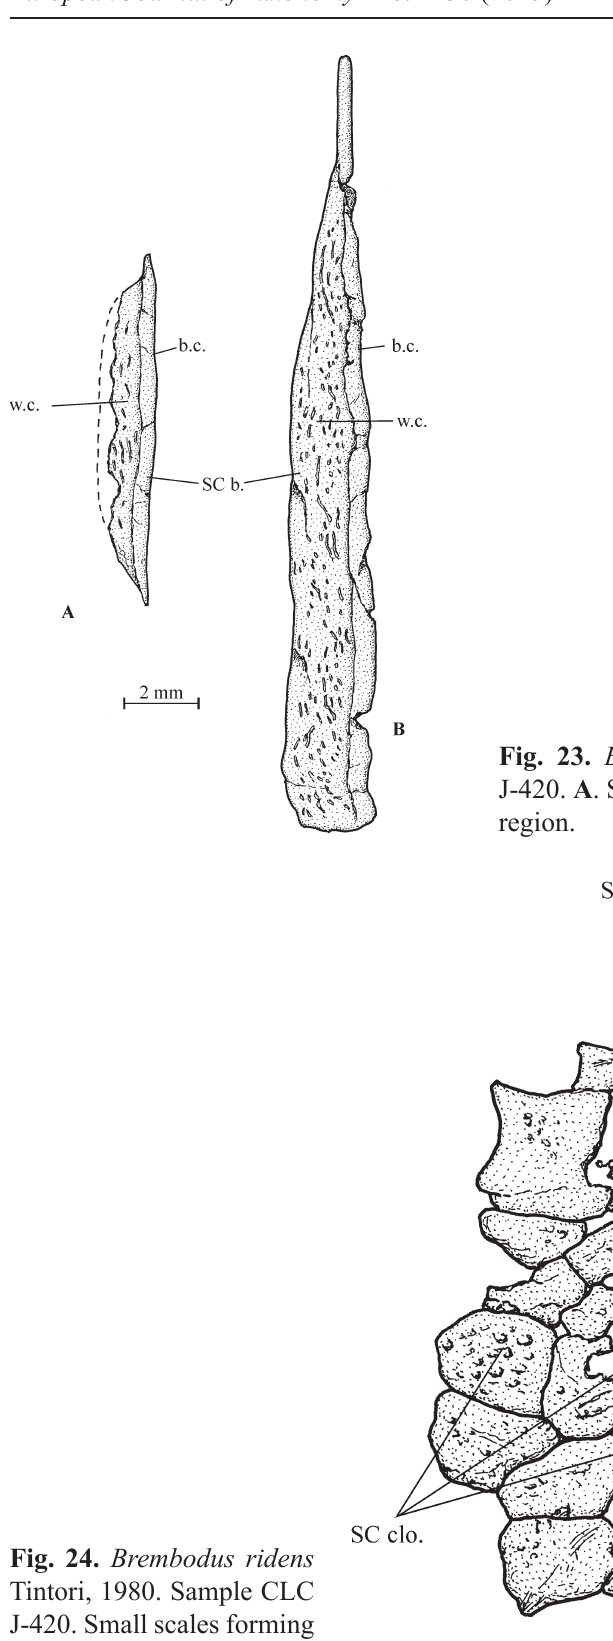
Fig. 24. Brembodus